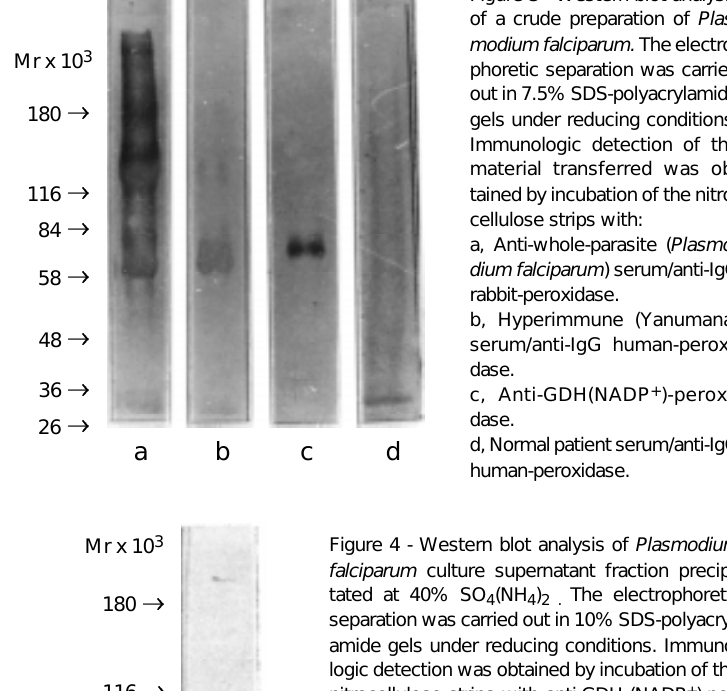
Figure 4 - Western blot analysis of Plasmodium